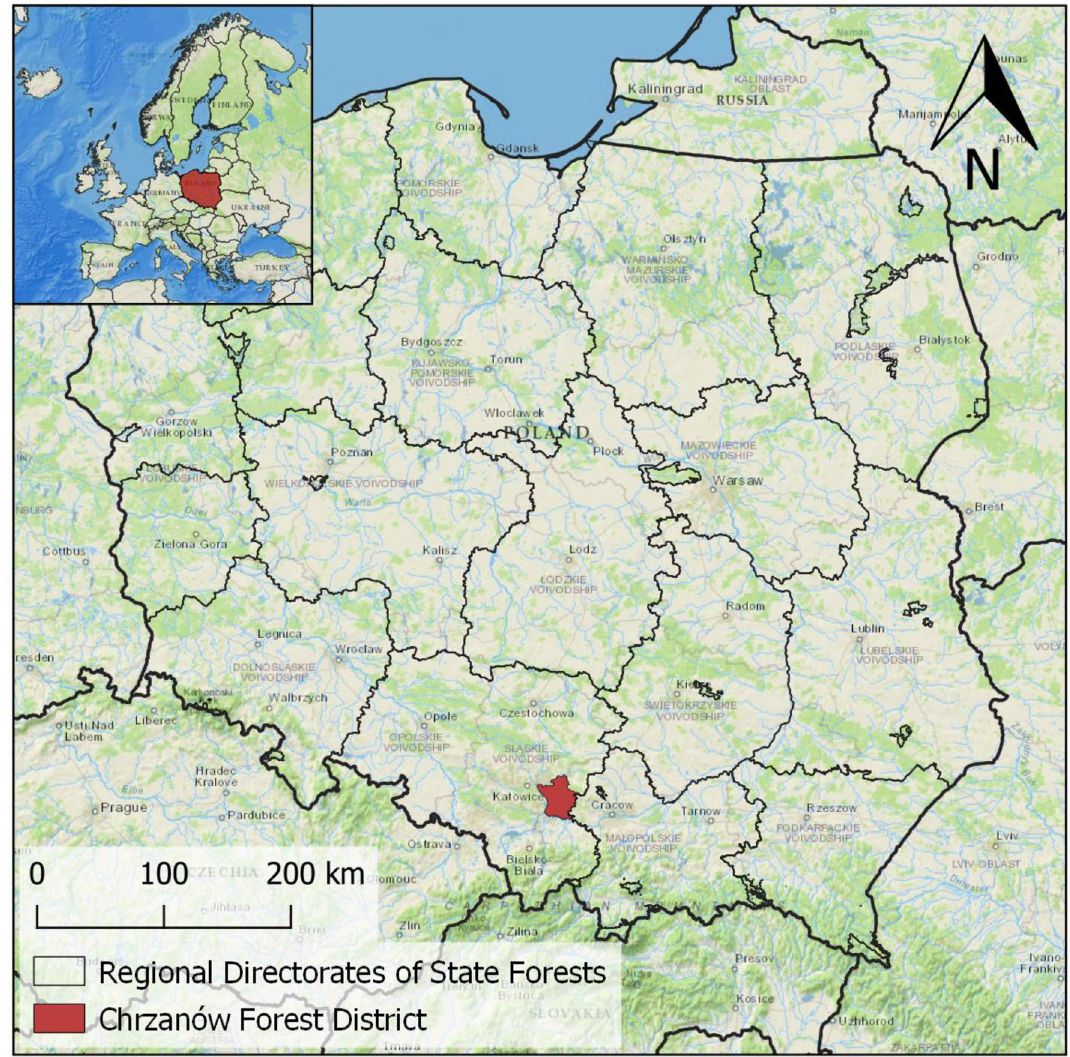
Figure 1. Map of the study location . QGIS 3.16 software (https:// www. esri. com/ en- us/ about/ about- esri/ overv iew) was used to create the map. The layer of the location map was the World Topographic Map basemap within QGIS 3.16 software. The map is credited to: Esri, HERE, DeLorme, Intermap, increment P Corp., GEBCO, USGS, FAO, NPS, NRCAN, GeoBase, IGN, Kadaster NL, Ordnance Survey, Esri Japan, METI, Esri China (Hong Kong), swisstopo, MapmyIndia, OpenStreetMap contributors, and the GIS User Calibration solutions had concentrations of 0.1 μg/ml, 0.2 μg/ml, 0.5 μg/ml, 1 μg/ml, and 2 μg/ml. Samples of the prepared solutions were dosed onto the chromatograph column. The generated chromatograms determined the standard curve. Later, soil samples were dosed in triplicate. At the end of each analysis, an "unknown" sample was applied, which was a 0.1 μg/ml calibration solution used as control material. Thirteen polycyclic aromatic hydrocarbons were analyzed in the soil samples: naphthalene (Nft), fluorene (Flu), phenanthrene (Phe), anthracene (Ant), fluoranthene (Flt), pyrene (Pyr), benzo(a)anthracene (BaA), and chrysene (Chr), benzo(k) fluoranthene (BkF), benzo(b)fluoranthene (BbF), benzo(a)pyrene (BaP), indeno(1,2,3-c,d)pyrene (IcdP), and bezo(g,h,i)perylene (BghiP). Enzymatic activity was determined using fluorogenic labeled substrates 35,36 . The fluorogenic enzyme sub- strates that were used for analysis were based on 4-methylumbelliferone (MUB). The following substrates were used: MUB-β-d-cellobioside for β-d-cellobiosidase (CB), MUB-β-d-xylopyranoside for xylanase (XYL), MUB-N-acetyl-β-d-glucosaminide for N-acetyl-β-d-glucosaminidase (NAG), MUB-β-d-glucopyranoside for β-glucosidase (BG) 37 . 2.75 g of soil from each sample was measured and mixed with 92 ml of universal buffer (pH 6.0). The resulting soil solution was pipetted into wells located on a microscope plate that contained the substrate and a modified universal buffer. Fluorescence was determined by incubating the soil suspension determined for 1.5 h at 35 °C in 96-well microplates (Puregrade, Germany). Fluorescence was then immediately determined on a multi-detector plate reader (SpetroMax), with excitation at 355 nm and emission at 460 nm. Carbon in microbial biomass (MBC) and nitrogen in microbial biomass (MBN) were determined by fumigation and extraction 38,39 .